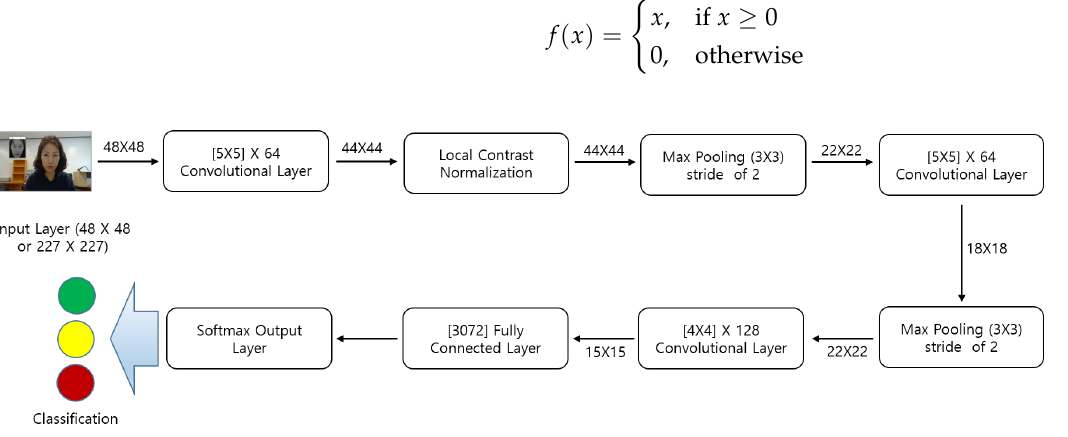
Figure 2. Overall procedure for expression classification using deep neural network (DNN) (convolutional neural networks (CNN)